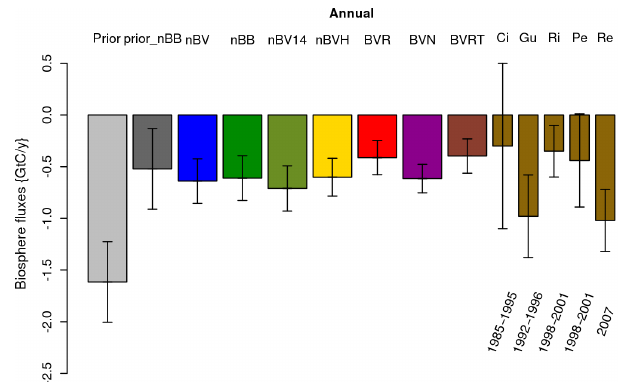
Figure 8. Annual European biogenic CO 2 fluxes in GtCyr − 1 for the different inversions and comparison to previous studies. Fluxes are upscaled to the TransCom EU domain. Labels of the references are as follows: Ci: Ciais et al. (2000); Gu: Gurney et al. (2004); Ri: Rivier et al. (2010); Pe: Peylin et al. (2013); Re: Reuter et al. (2014). Periods for the inverted fluxes are given below the flux